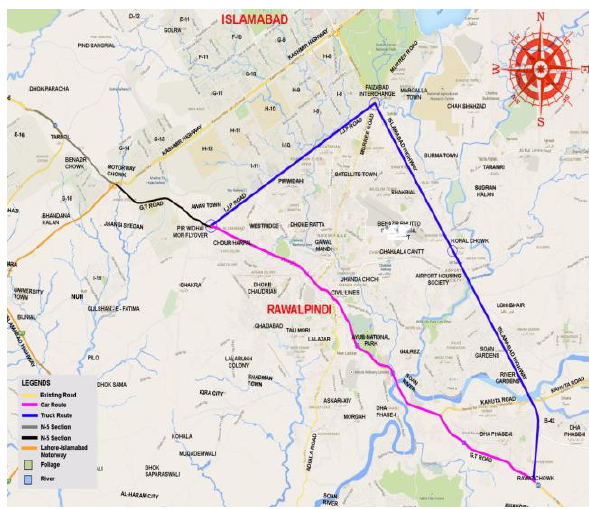
Figure 1: Existing Scenario / Do nothing scenario